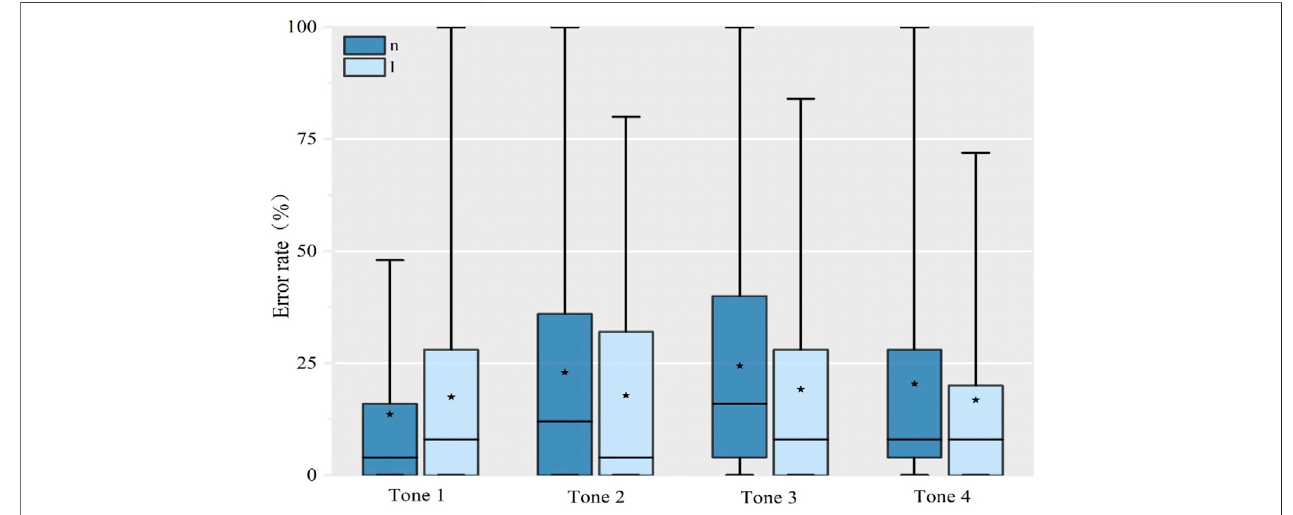
FIGURE 6 | Error rate of production of Standard Mandarin words by